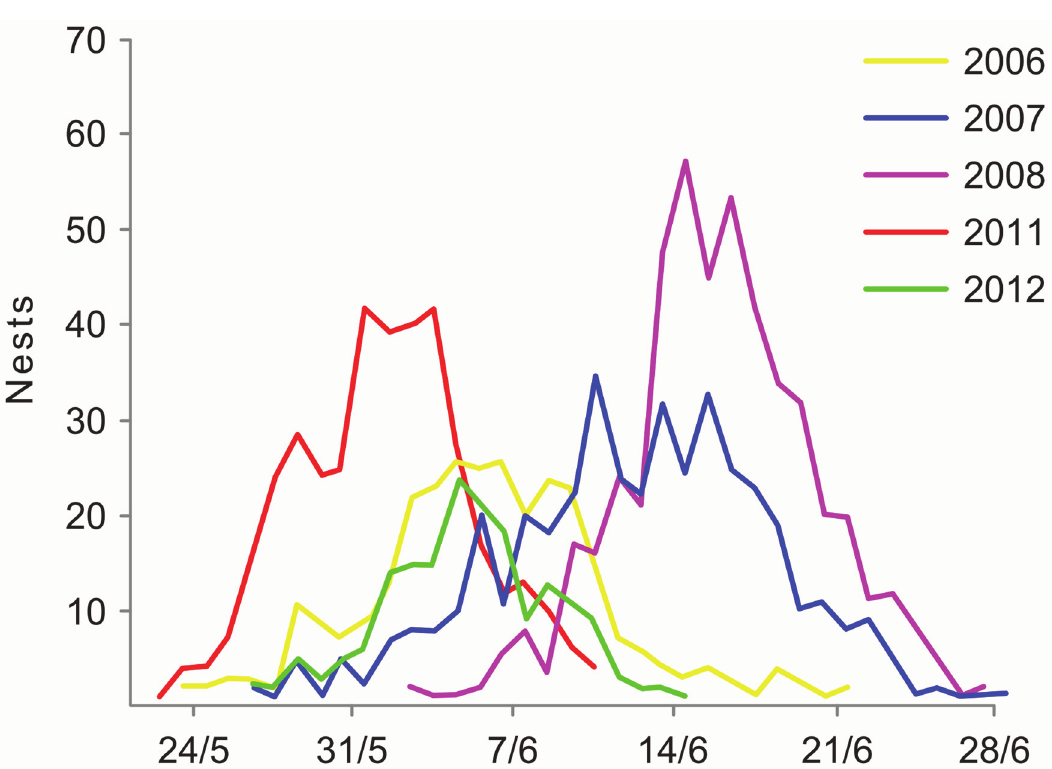
Fig 5. Nest initiation dates of white-fronted geese in 2006 – 2012 on Kolguev Island, Russia. From the report of the expeditions to Kolguev by Institute for Waterbird and Wetlands Research [39].